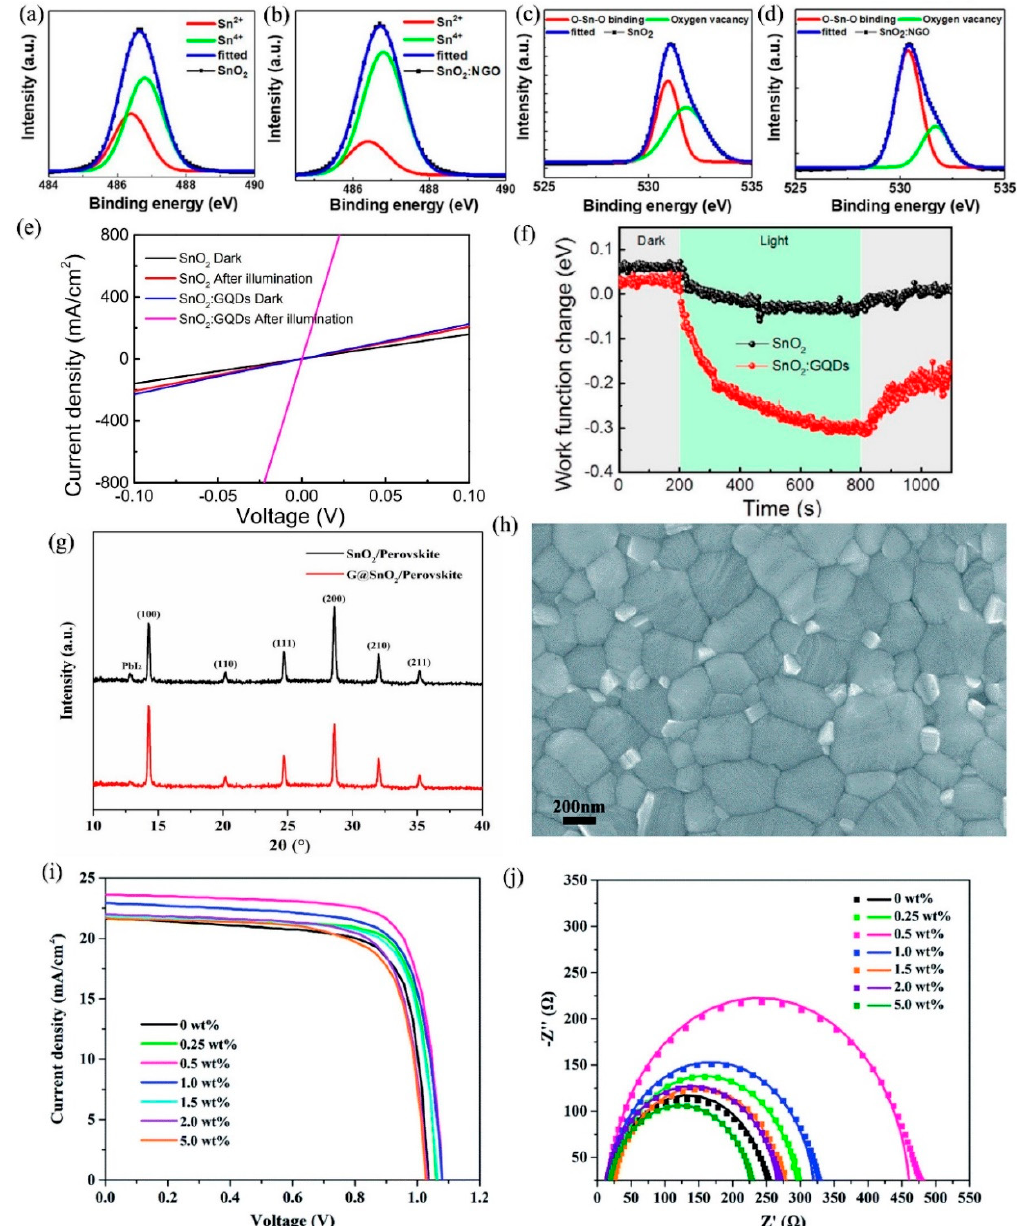
Figure 5. Sn 3d 5/2 XPS spectra for ( a ) SnO 2 , ( b ) SnO 2 -NGO; O 1s XPS spectra for ( c ) SnO 2 , ( d ) SnO 2 -NGO [26] (republished with permission from American Chemical Society); ( e ) J-V characteristics of the ETL-only devices (Ag / SnO 2 / ITO and Ag / SnO 2 -GQD / ITO under illuminated (simulated sunlight, the global standard spectrum (AM 1.5 G)) and dark conditions; ( f ) work function changes of ETL-only devices under illuminated and dark conditions [56] (republished with permission from American Chemical Society); ( g ) XRD patterns of perovskite films on SnO 2 and SnO 2 -GQD; ( h ) top-view SEM image of perovskite with excess of PbI 2 ; ( i ) J-V curves and ( j ) Nyquist plots (in the dark at a bias of –1.0 V) of PSCs based on SnO 2 with di ff erent GQDs (5 nm Ø) concentrations [24] (republished with permission from Royal Society of Chemistry, conveyed through Copyright Clearance Center,